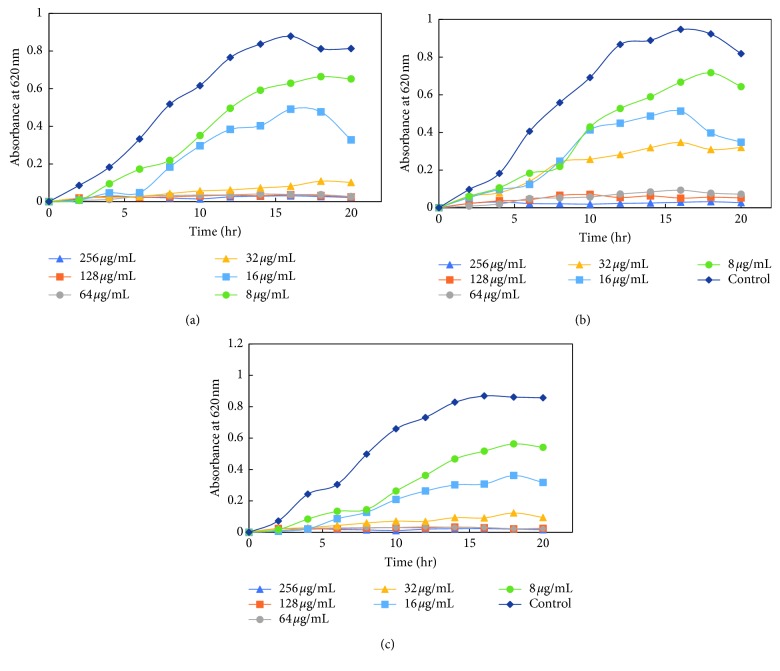
Growth kinetics of extended-spectrum β-lactamases- (ESβL-) producing E. coli. Growth kinetics of (a) ECESβL1, (b) ECESβL2, and (c) ECESβL3 in presence of varying concentrations of MK-AgNPs.